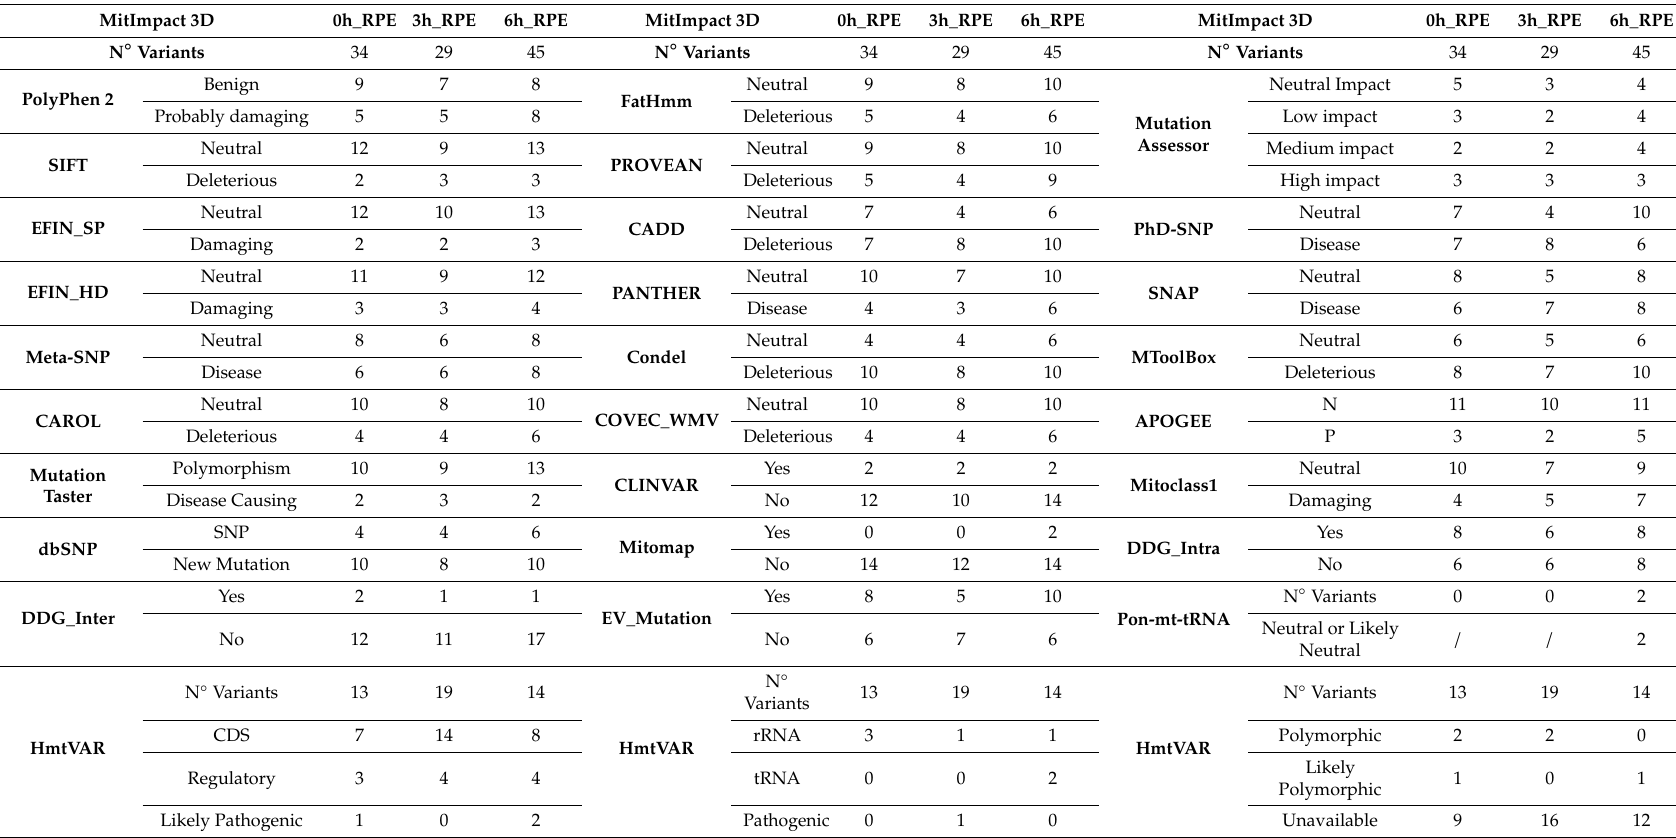
Table 3. In-silico functional prediction analyses report. Table shows principal results on pathogenicity prediction of identified variants through all samples. The main macro-resources used are highlighted in